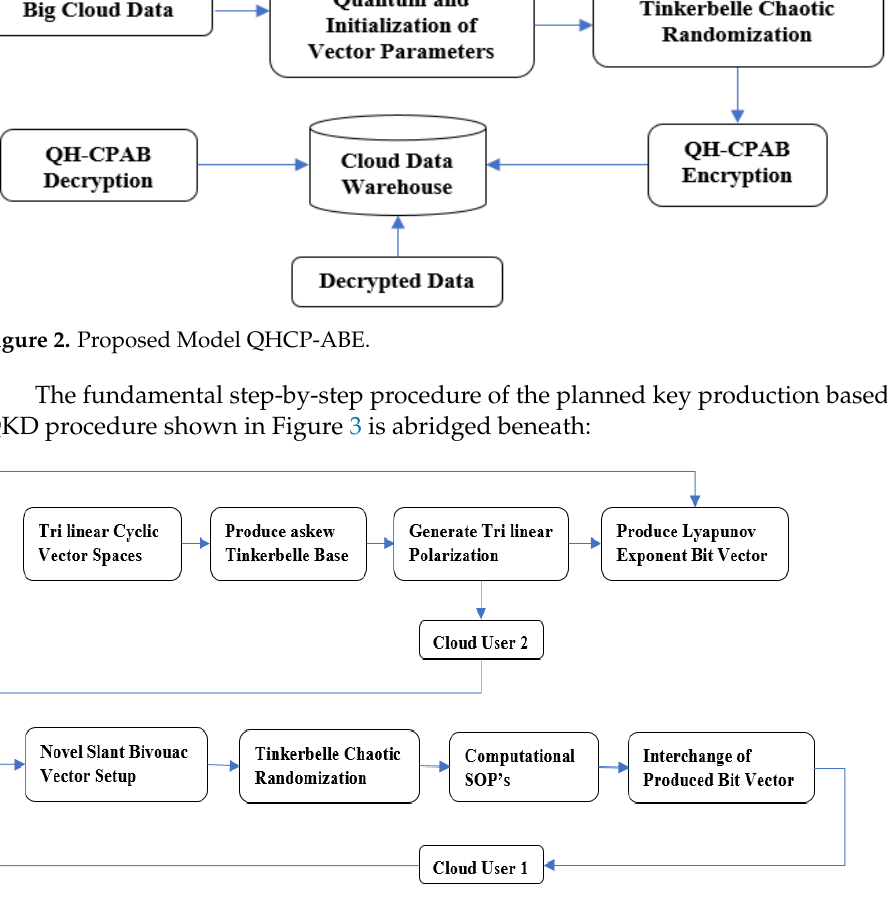
Figure 2. Proposed Model QHCP ‐ ABE.